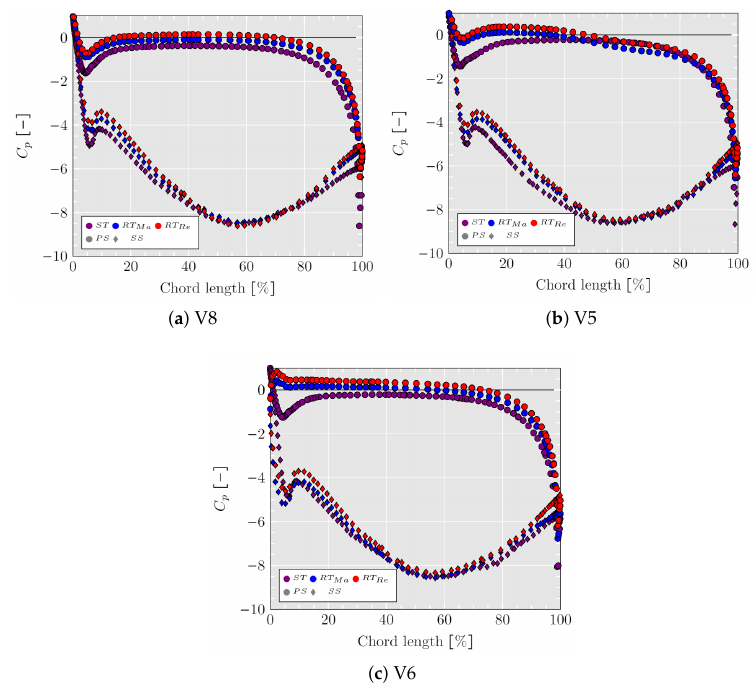
Figure 8. C p for each studied vane. ST and RT; VGT30; 0.5 mm tip height. In the figure, legend colors stand for each case, while shapes in gray determine each of the vane faces.